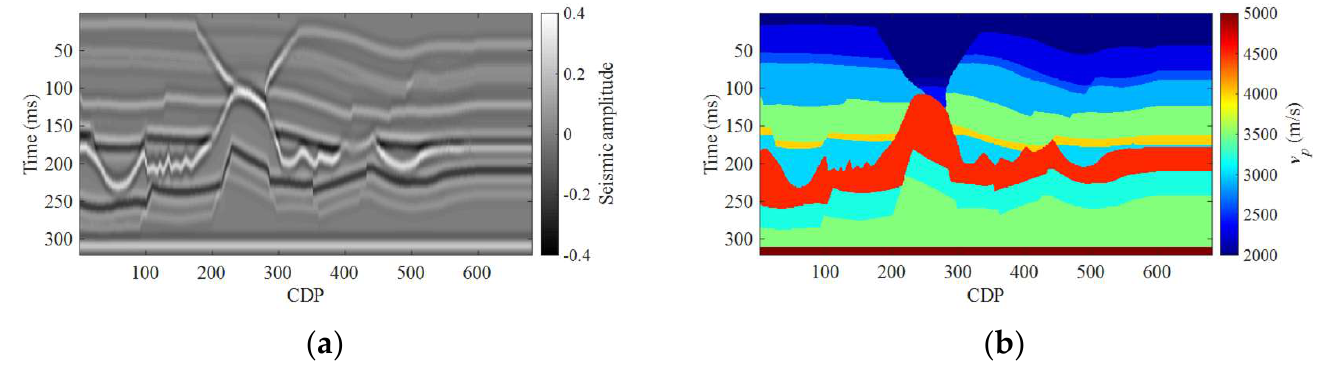
Figure 4. ( a ) The synthetic clean observed poststack seismic record, ( b ) true P-wave velocity of the salt dome intrusion model.